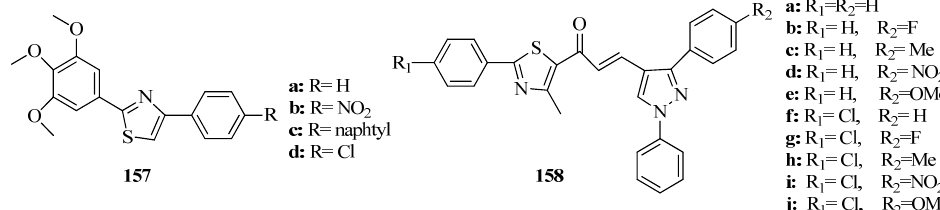
Figure 61. Structures of 4,5-disubstituted 2-(trimethoxyphenyl)thiazoles and thiazole-based chal cones.